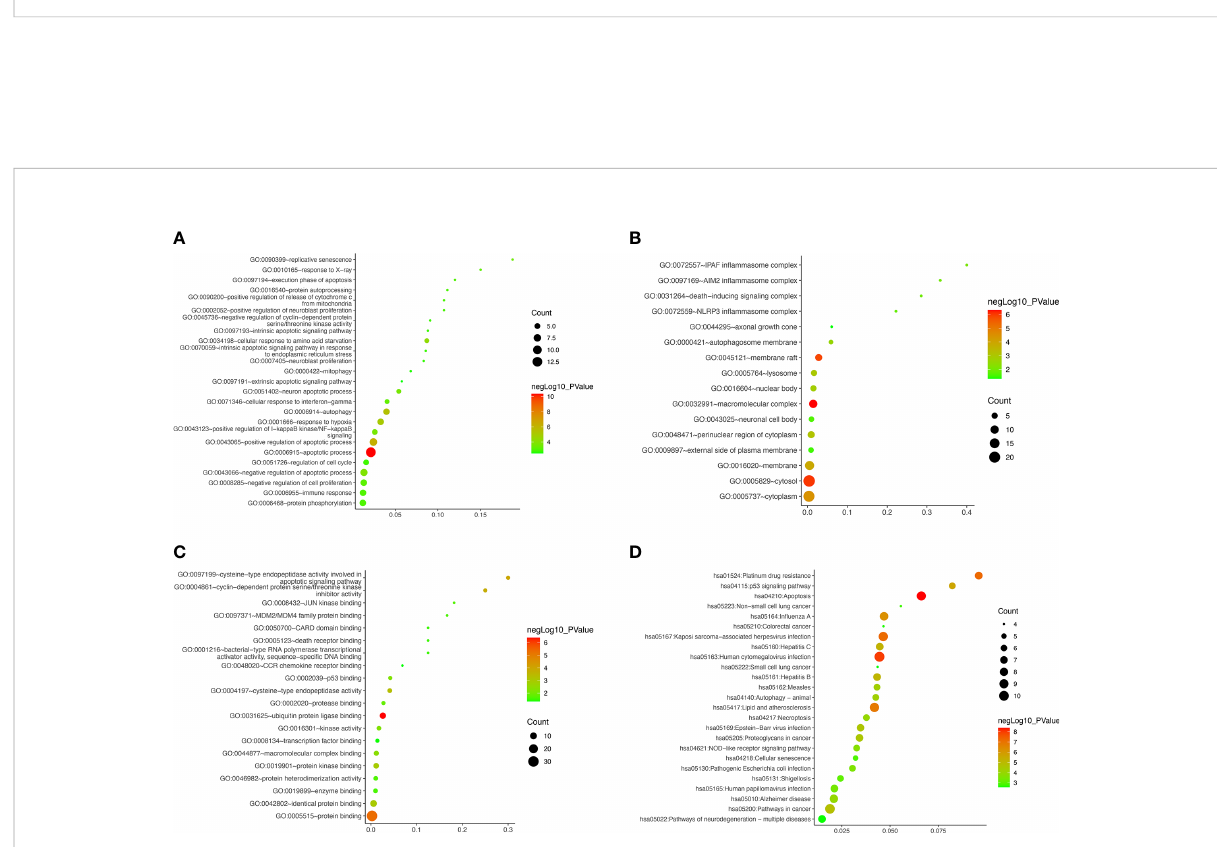
FIGURE 6 Gene ontology and Kyoto Encyclopedia of Genes and Genomes Pathway Enrichment of differentially expressed autophagy-related genes. (A – D) Bubble plot for biological processes, cellular components, molecular functions, and enriched pathways, respectively.